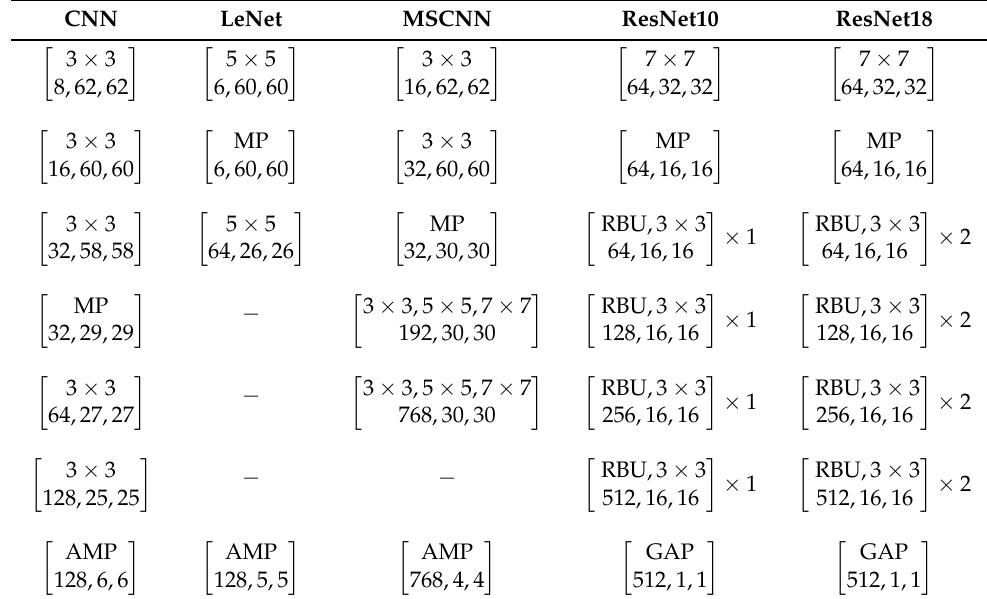
Table 3. Feature size output by each layer of the DL